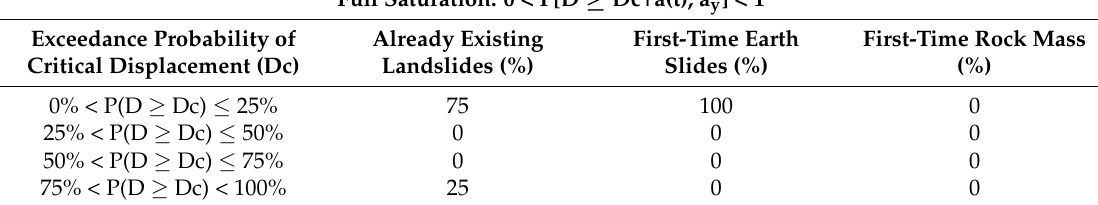
Table 10. Probability of exceedance values computed in the full saturations scenario for different landslide